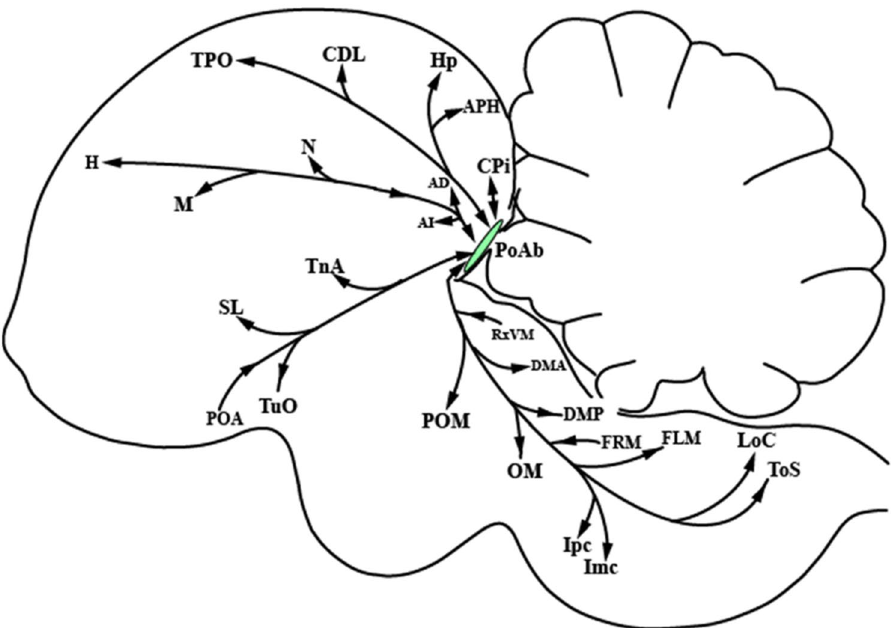
Figure 3. Models of main pathways of PoAb in the pigeon brain. Arrowheads at end of arrows show reciprocal connections, whereas those present midway indicate one-way projections. AD arcopallium dorsale; AI arcopallium intermedium; APH area parahippocampalis; CDL area corticoidea dorsolateralis; CPi cortex piriformis; DMA nucleus dorsomedialis anterior thalami; DMP nucleus dorsomedialis posterior thalami; FLM fasciculus longitudinalis medialis; FRM formatio reticularis medialis mesencephali; H hyperpallium; Imc nucleus isthmi, pars magnocellularis; Ipc nucleus isthmi, pars parvocellularis; LoC locus ceruleus; M mesopallium; N nidopallium; OM tractus occipito-mesencephalicus; POA nucleus preopticus anterior; PoAb basal division of posterior pallial amygdala; POM nucleus preopticus mediali; RxVM radix mesencephalicus nervi trigemini; SL nucleus septalis lateralis; SP nucleus subpretectalis; TnA nucleus taeniae amygdalae; TPO area temporo–parieto–occipitalis; Tuo tuberculum